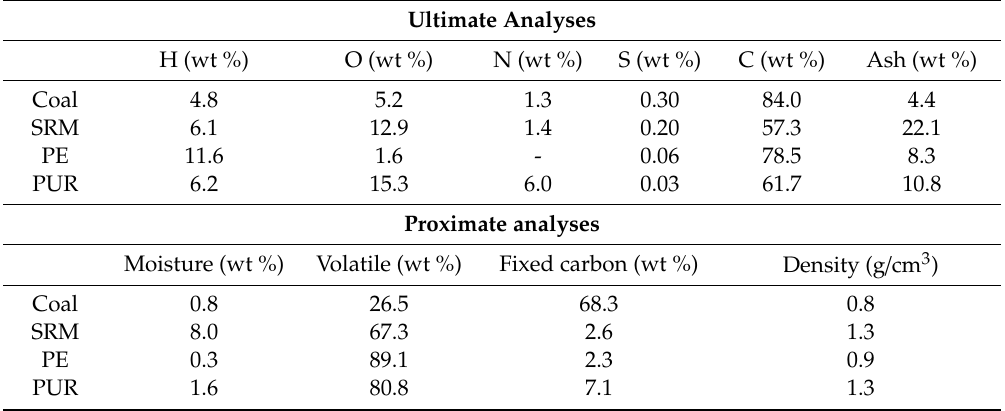
Table 1. Characterization of materials, including ultimate and proximate analyses and